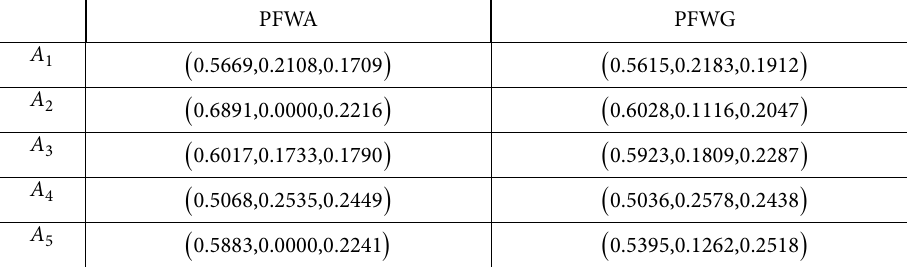
Table 8. The fused values by using the PFWA and PFWG operators